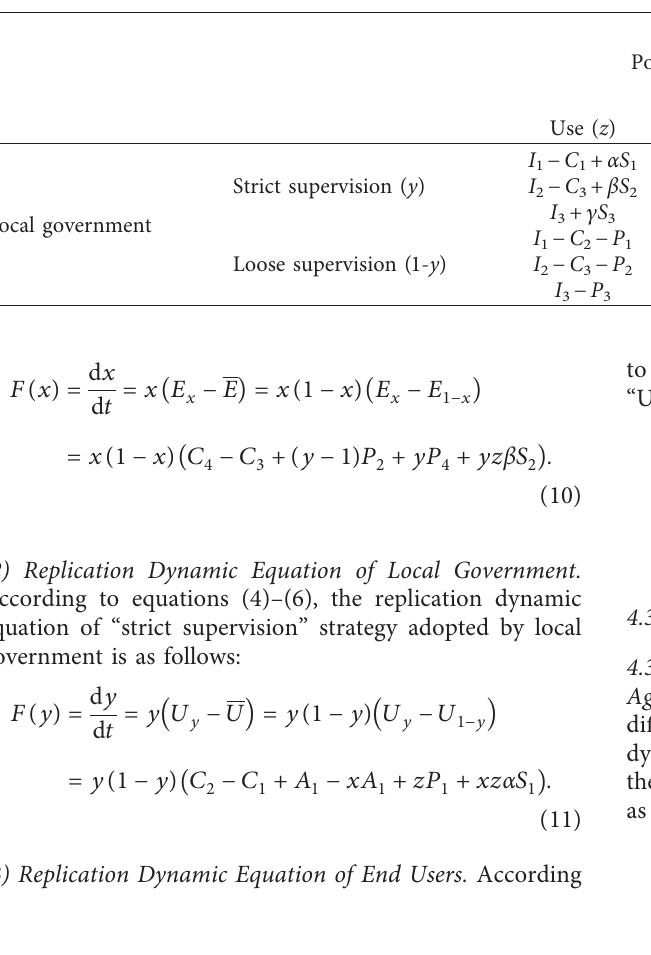
Table 2: Payment matrix of functional departments, local governments, and end